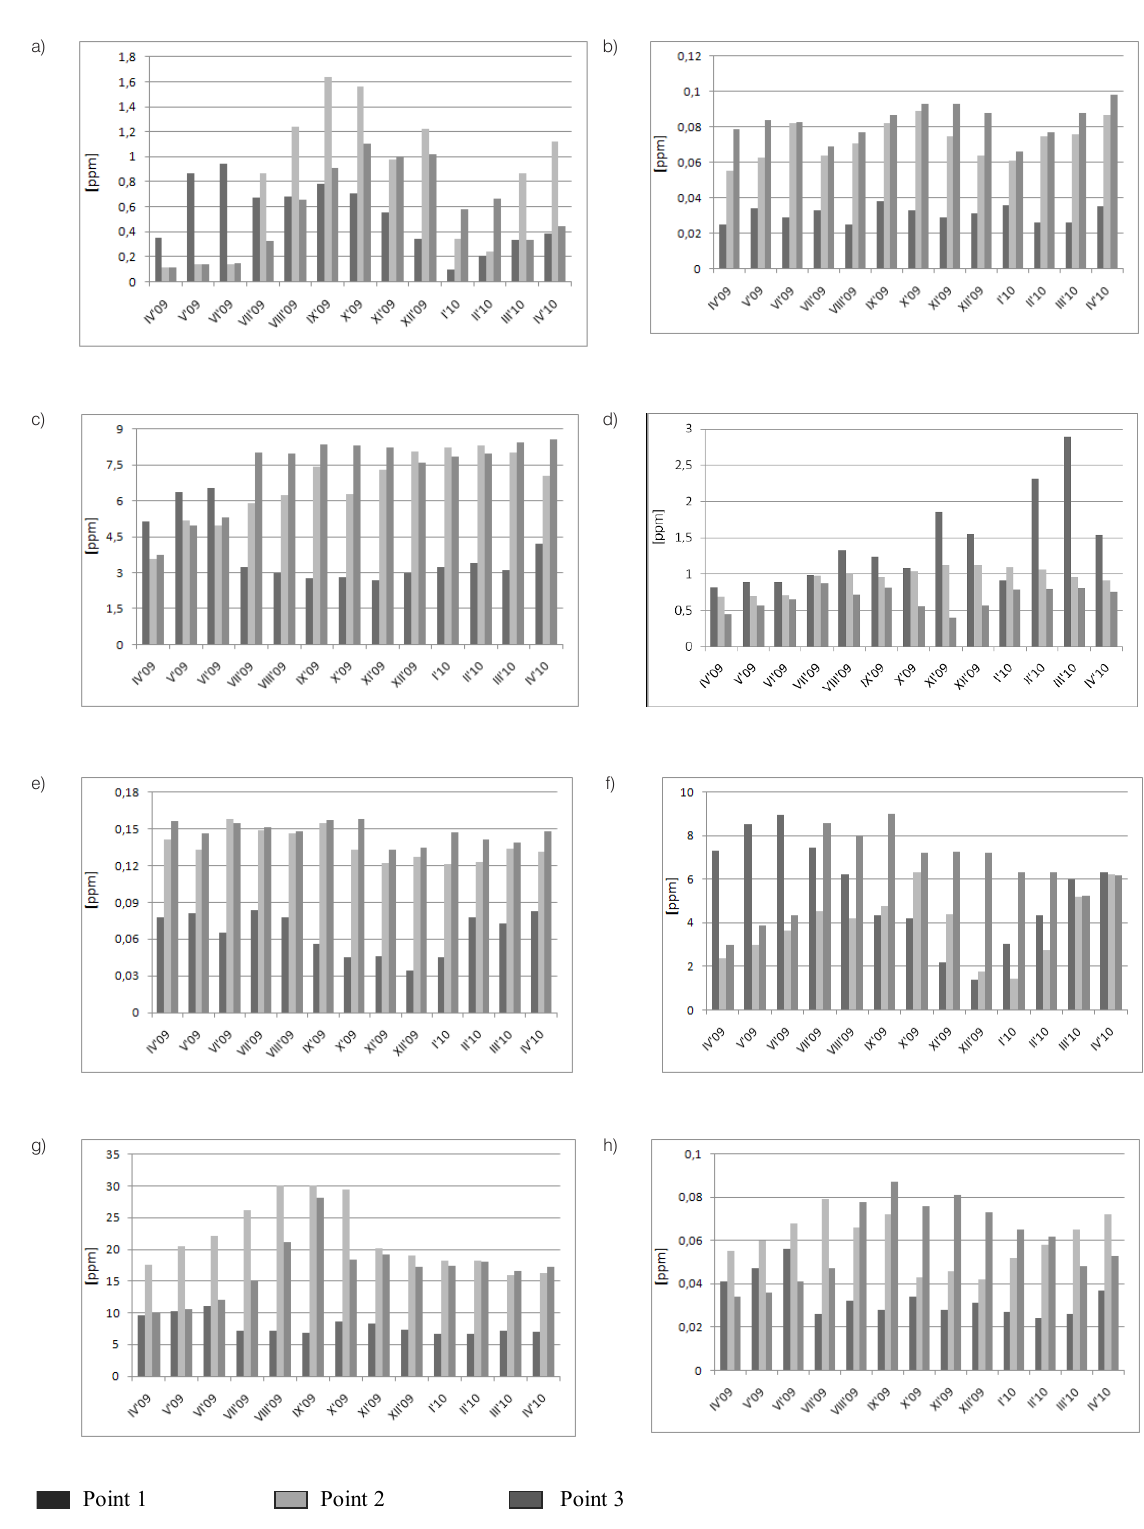
Figure 4. Total metal concentrations in individual sampling point, where: a) Cd, b) Cu, c) Cr, d) Fe, e) Mn, f) Ni, g) Pb and h)